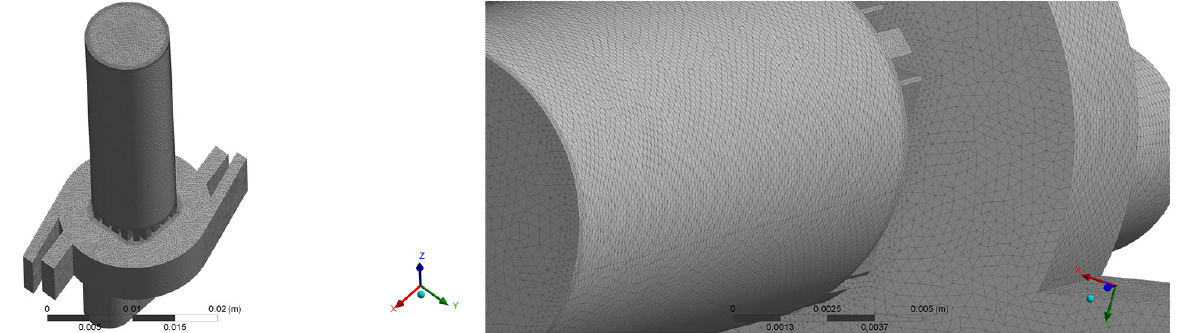
Figure 2. Meshing of the DPI geometry.